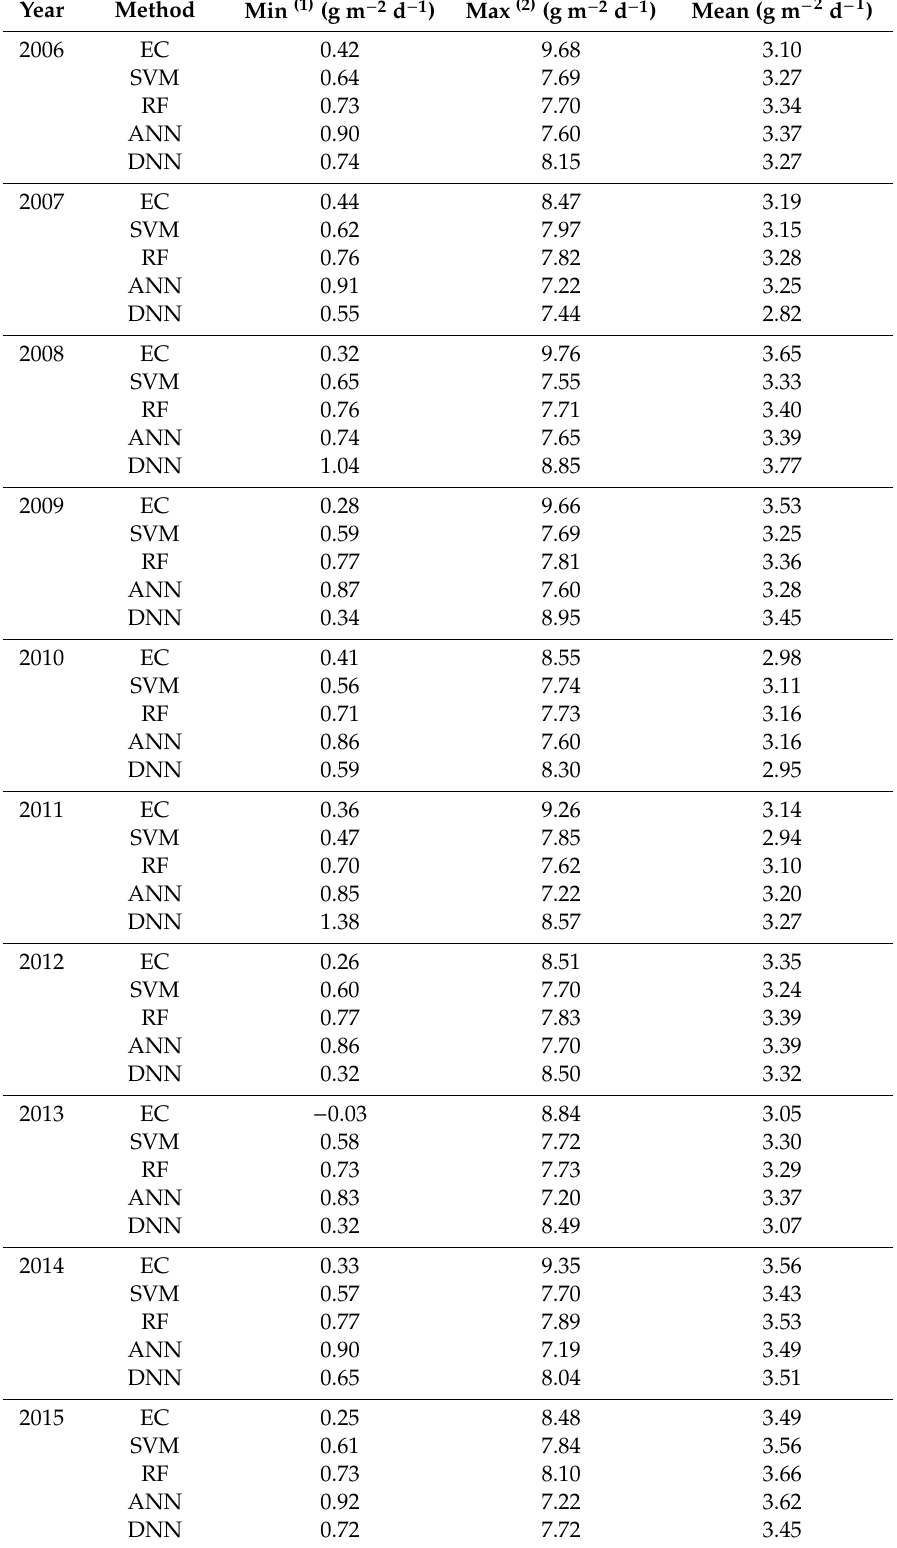
Table 3. Statistics of daily gross primary productivity (GPP) at the Gwangneung site for each year between 2006 and 2015, measured by eddy covariance (EC) and predicted by support vector machine (SVM), random forest (RF), artificial neural network (ANN), and deep neural network